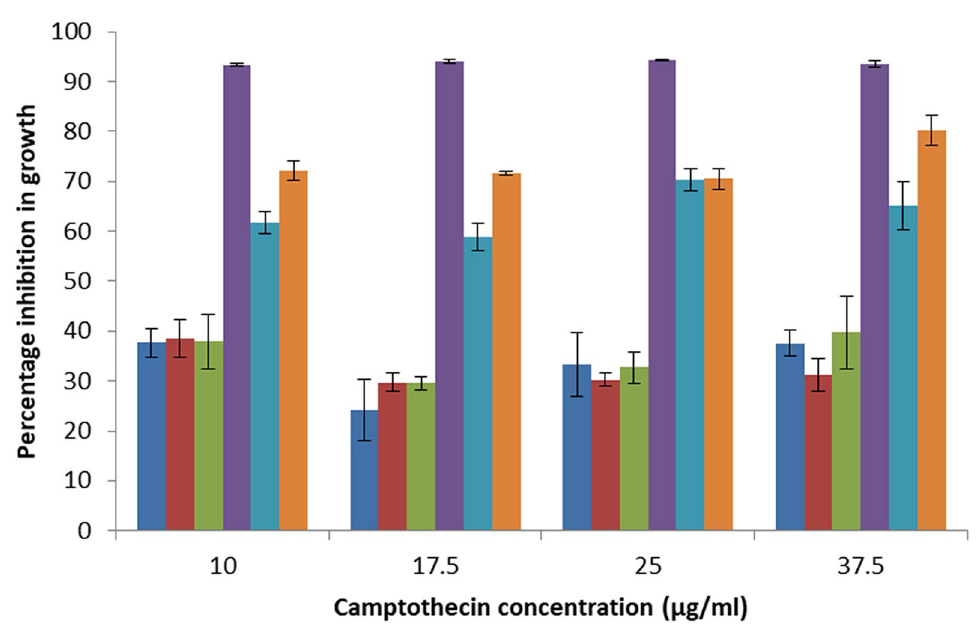
Figure 4. Percentage inhibition in growth of non camptothecin producing strains ( NCPT1, NCPT2 and NCPT3) in comparison to the camptothecin producing strains ( CPT1, CPT2 and CPT3) with increasing concentrations of standard camptothecin in